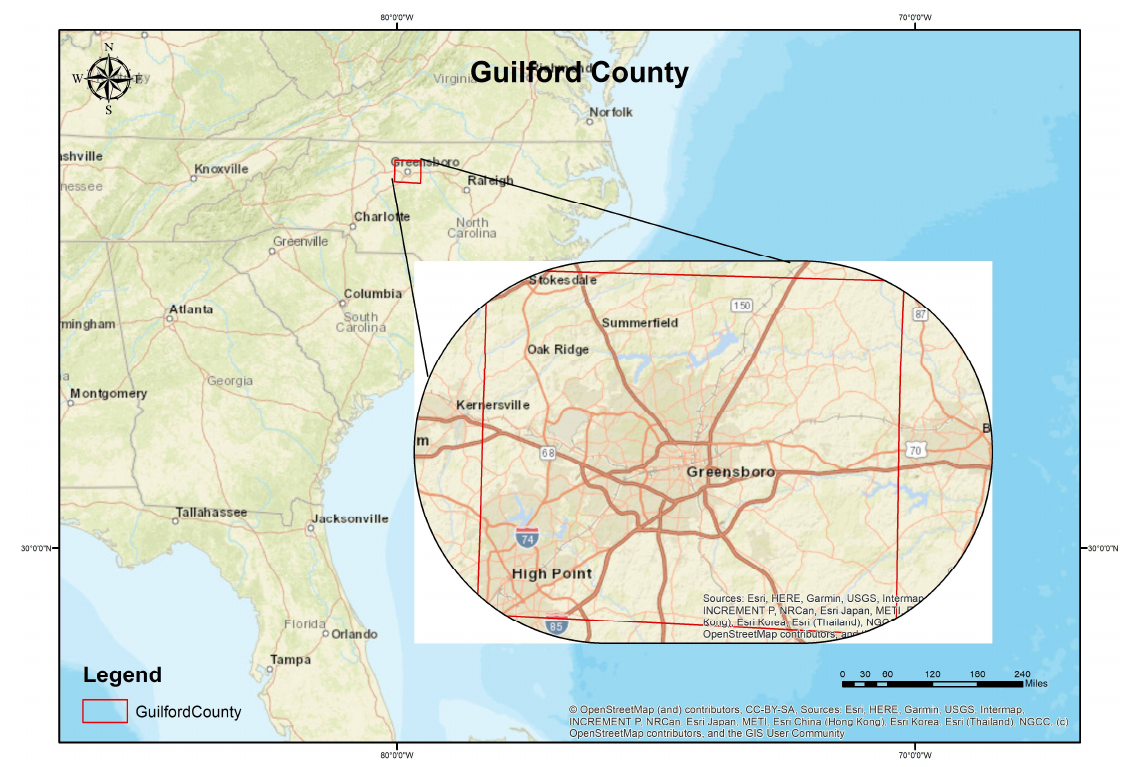
Figure 1. Study Area: Guilford County, North Carolina.